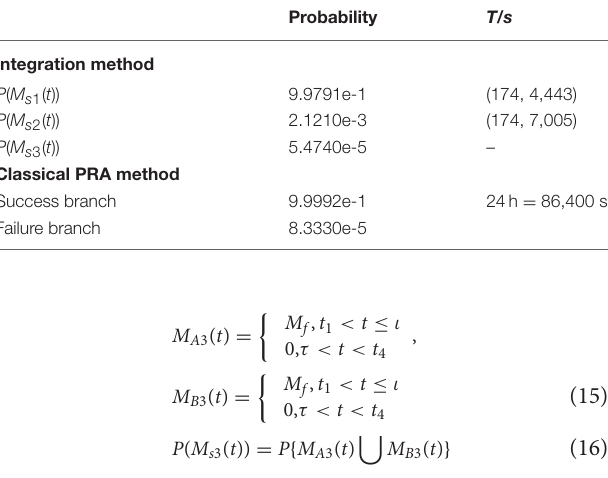
TABLE 8 | Conditional probability of LPI